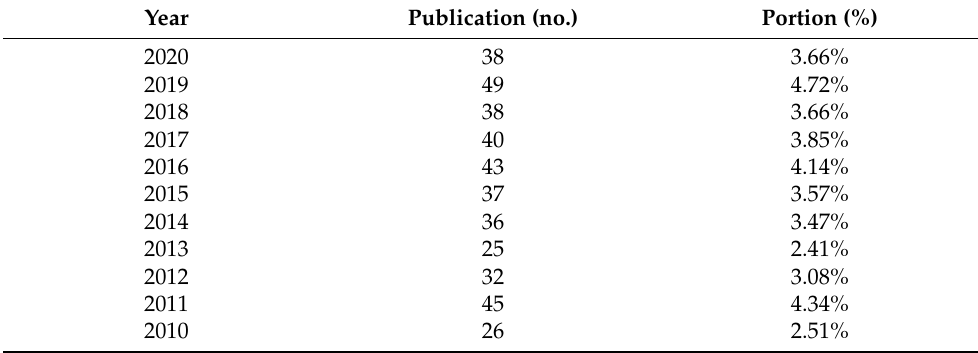
Figure 2. The number of scientific documents published on industrial effluent and sludge toxicity performed on industrial wastewater from 1950 to 2020 ( a ). Fitted curve and cumulative number of publication in the adopted duration ( b ). Table 1. The number of published documents in the last 10 years and the respective percentage of the publications in each year.